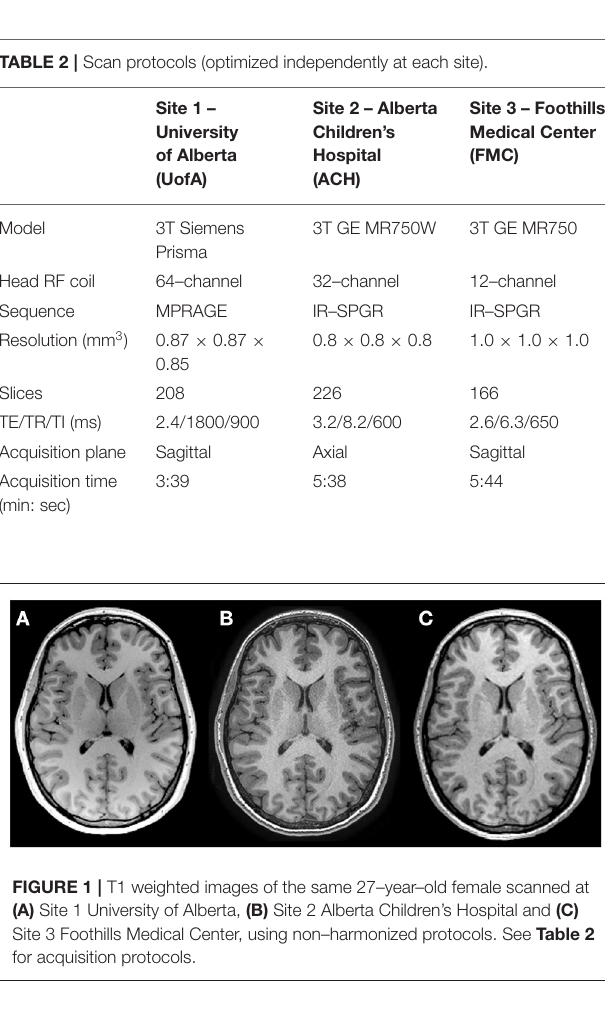
corrected data in this subset. Note that ComBat correction was run separately in this cohort given that ComBat cannot be run ad–hoc on single